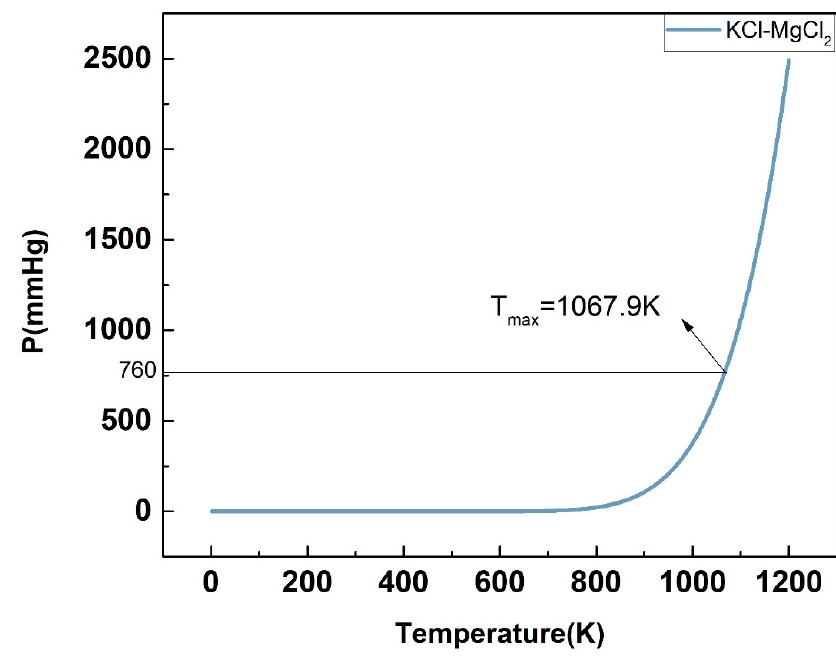
Figure 21. Calculated P-T phase diagram of the KCl-MgCl 2 binary system.